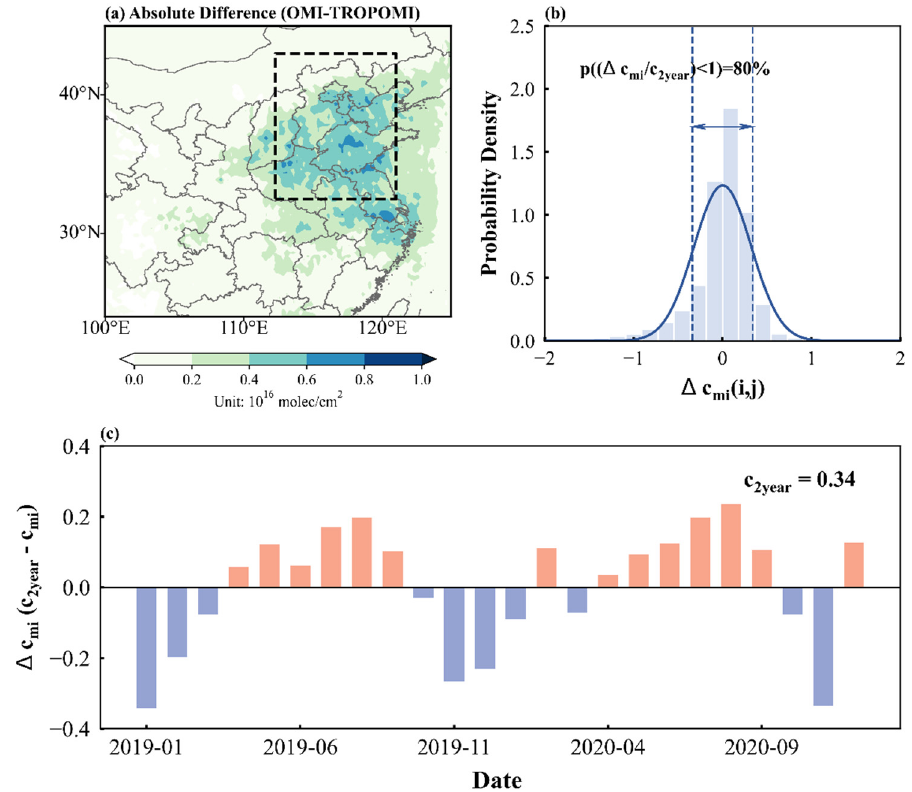
Figure 4. ( a ) The map of the absolute difference between OMI and TROPOMI NO 2 VCDs averaged during 2019 and 2020 (i.e., c n ( i , j ) in Equation (3)). Black box represents the NCP area. ( b ) Probability density distribution diagram of the ∆ c mi ( i , j ) for all months and all pixels over the NCP region in 2019–2020. ( c ) Bar-chart plot representing the temporal evolution of the regional mean ∆ c mi (units: 10 16 molec cm − 2 ).